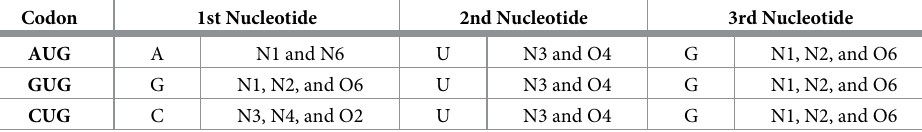
Table 1. Codons modeled in our simulation. Nucleotide sequence and reference atoms to define the codon-anticodon distance. Codon 1st Nucleotide 2nd Nucleotide 3rd Nucleotide AUG A N1 and N6 U N3 and O4 G N1, N2, and O6 GUG G N1, N2, and O6 U N3 and O4 G N1, N2, and O6 CUG C N3, N4, and O2 U N3 and O4 G N1, N2, and